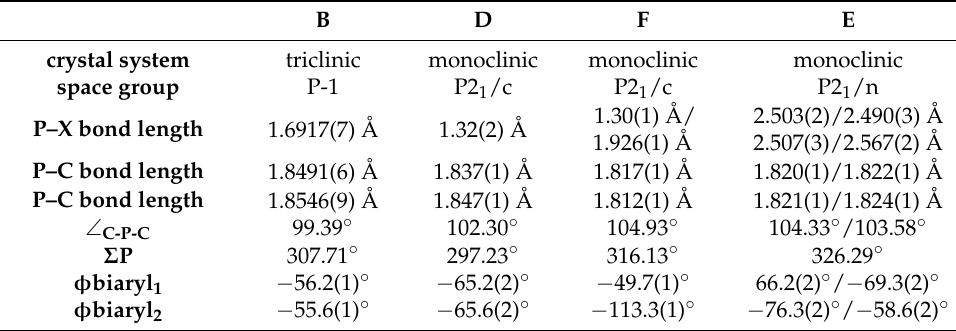
Figure 1. Overview of molecule structures. All carbon-bonded hydrogen atoms were removed for clarity. Table 1. Overview key crystal structure details for B , D , F and E